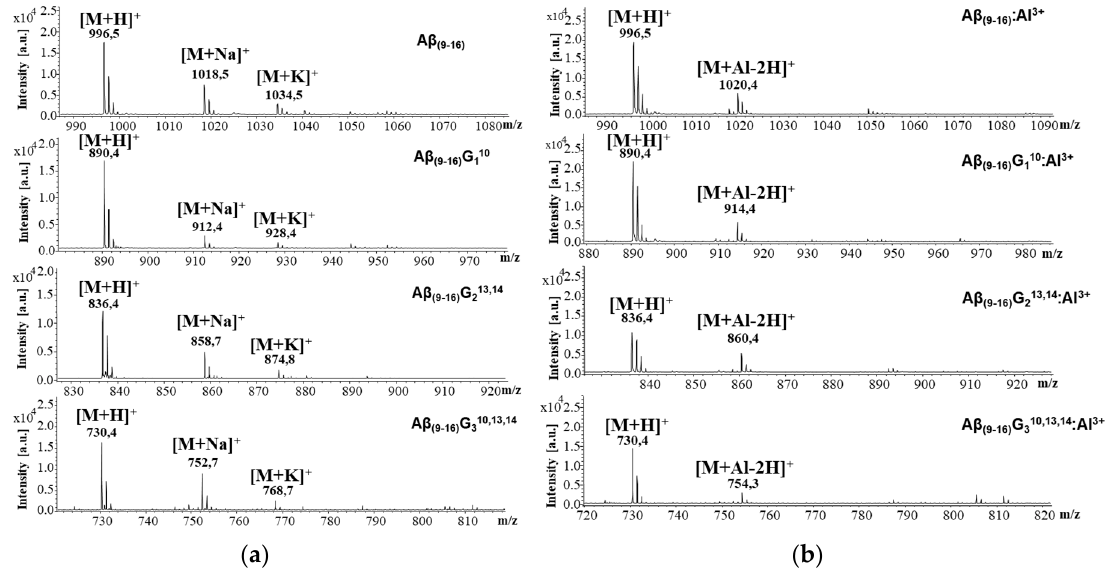
Figure 5. Matrix-assisted laser desorption ionization time-of-flight mass spectrometry ( MALDI-ToF MS) analysis of ( a ) A β (9–16) peptide (GYEVHHQK-NH 2 ) and its glycine analogues: A β (9–16) G 110 ,